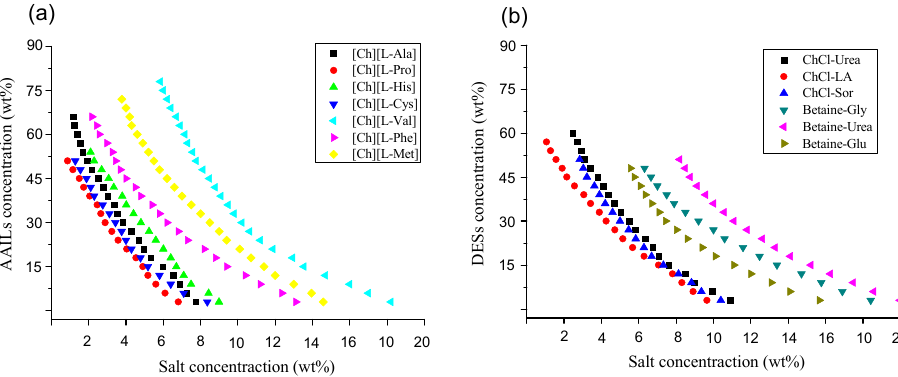
Figure 1. The phase diagrams for different ATPSs (aqueous two-phase systems): ( a ) ChAAILs (choline-amino acid ionic liquids)/K 3 PO 4 and ( b ) DESs (deep eutectic solvents)/K 3 PO 4 at T = 298.15 K.